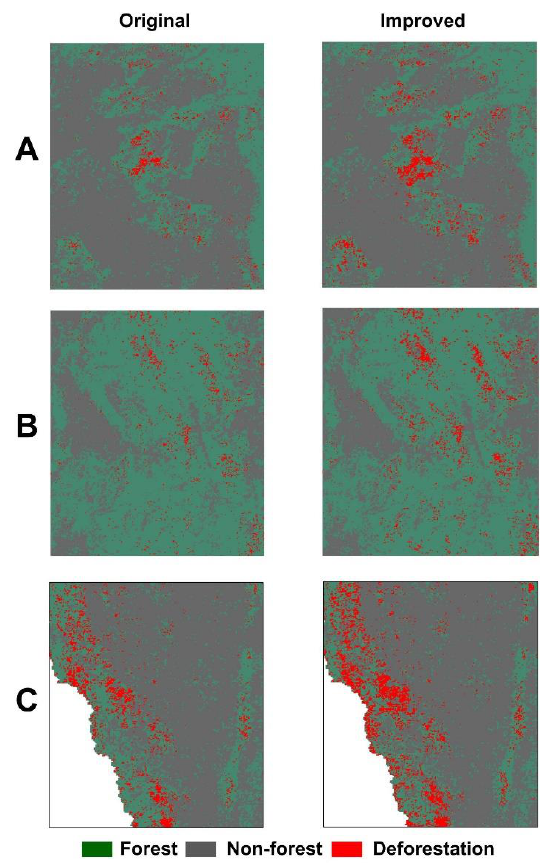
Figure 2. Forest change maps from original (left) and improved time series IFZ (right) pairs over three study sites ( A – C ).